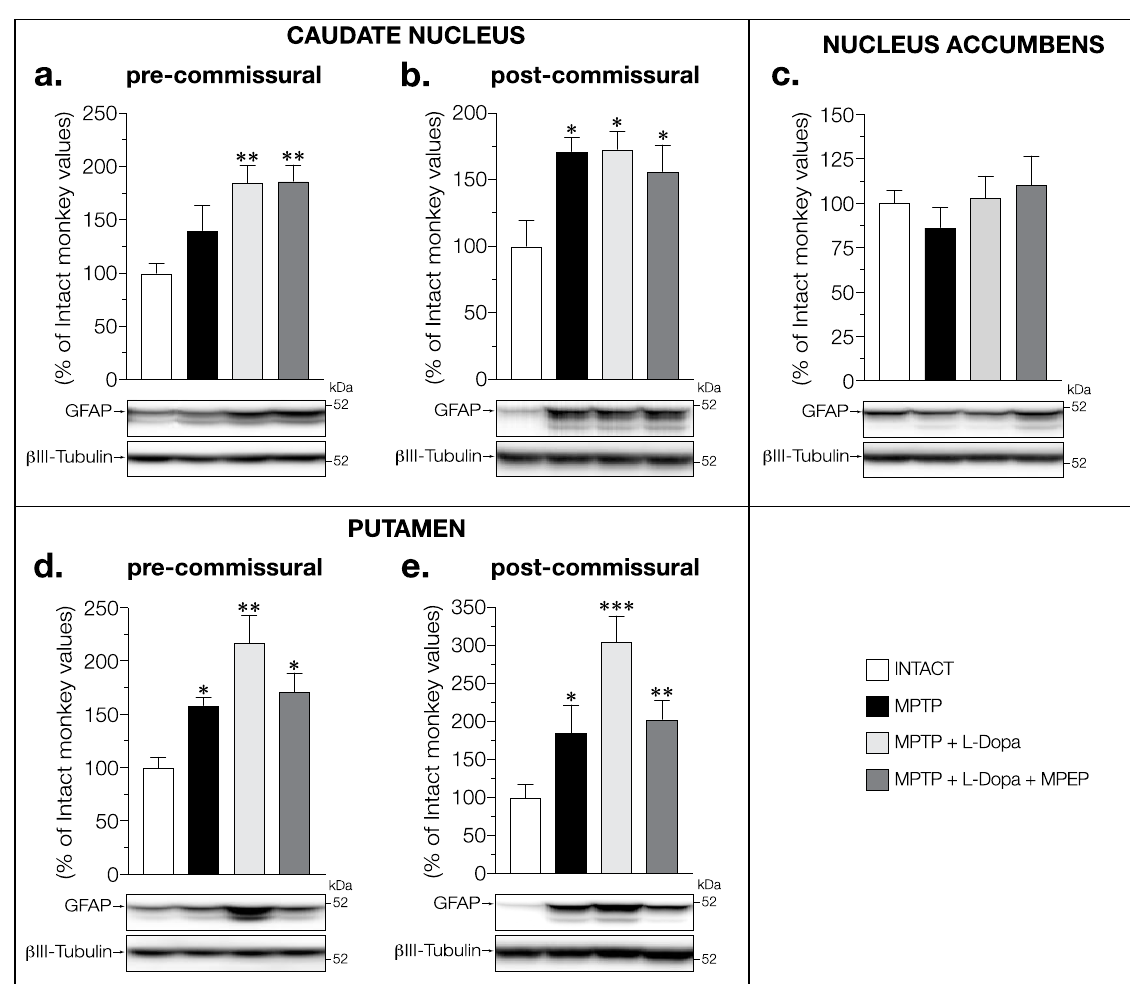
Figure 3. Western blots for GFAP protein levels in ( a , b ) caudate nucleus, ( c ) nucleus accumbens, and ( d , e ) putamen of intact monkeys (control), MPTP monkeys treated with saline, L-Dopa, and L-Dopa + MPEP. Values are means of arbitrary units expressed as percentage of control ( β III-tubulin was used as internal loading control) of 3–4 independent experiments ± standard error of mean of 4–5 monkeys per group. * p < 0.05, ** p < 0.01 and *** p < 0.001 vs. INTACT.